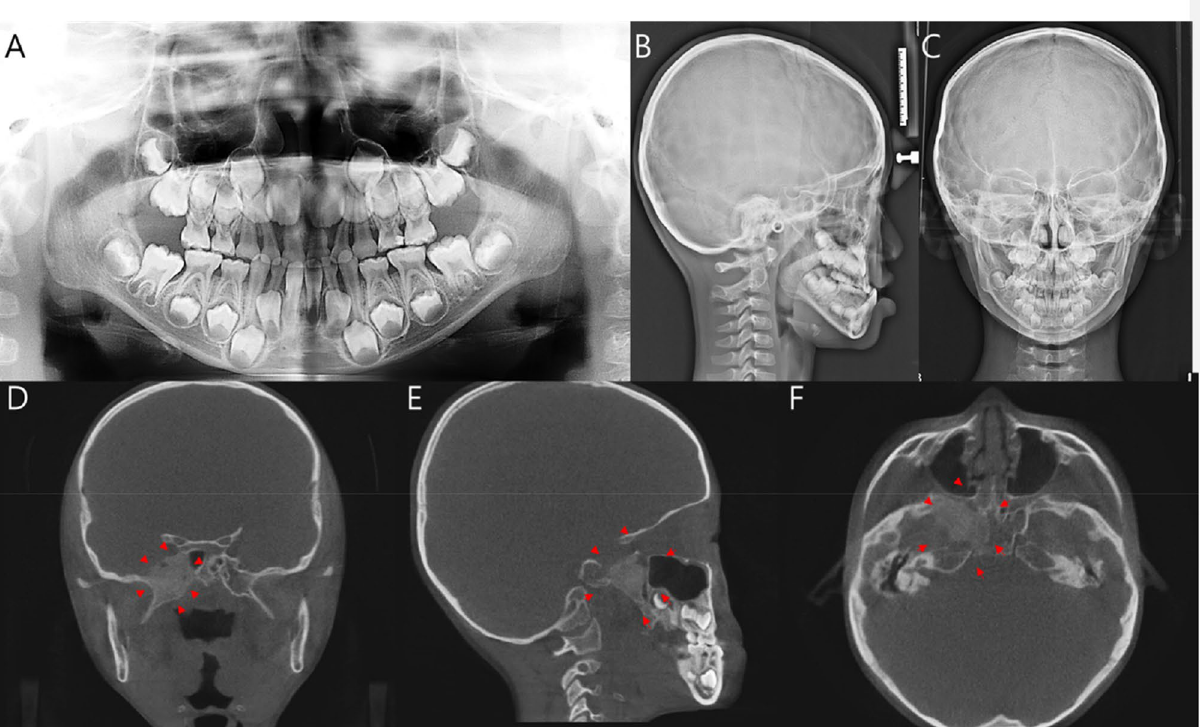
Figure 1. Fibrous dysplasia of the right sphenoid sinus was found on the 3D CBCT images of a 6-year-old male patient. The cortex had been thinned but was still intact, and granular internal bone pattern was observed on CBCT images, while no abnormal structures found on 2D radiographic images. ( A ) Panoramic radiograph, ( B ) lateral cephalogram, ( C ) postero-anterior cephalogram, ( D – F ) slices of CBCT showing abnormal bone